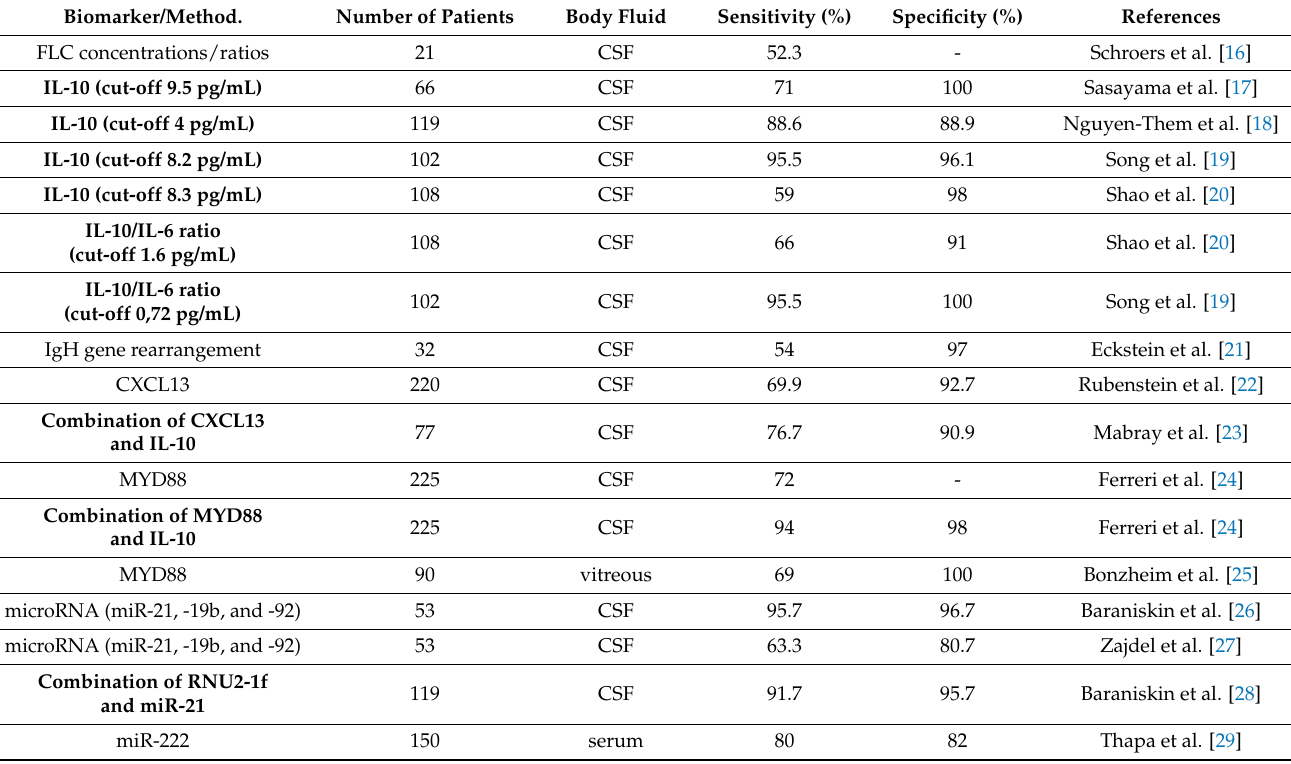
Table 2. Overview of the novel diagnostic